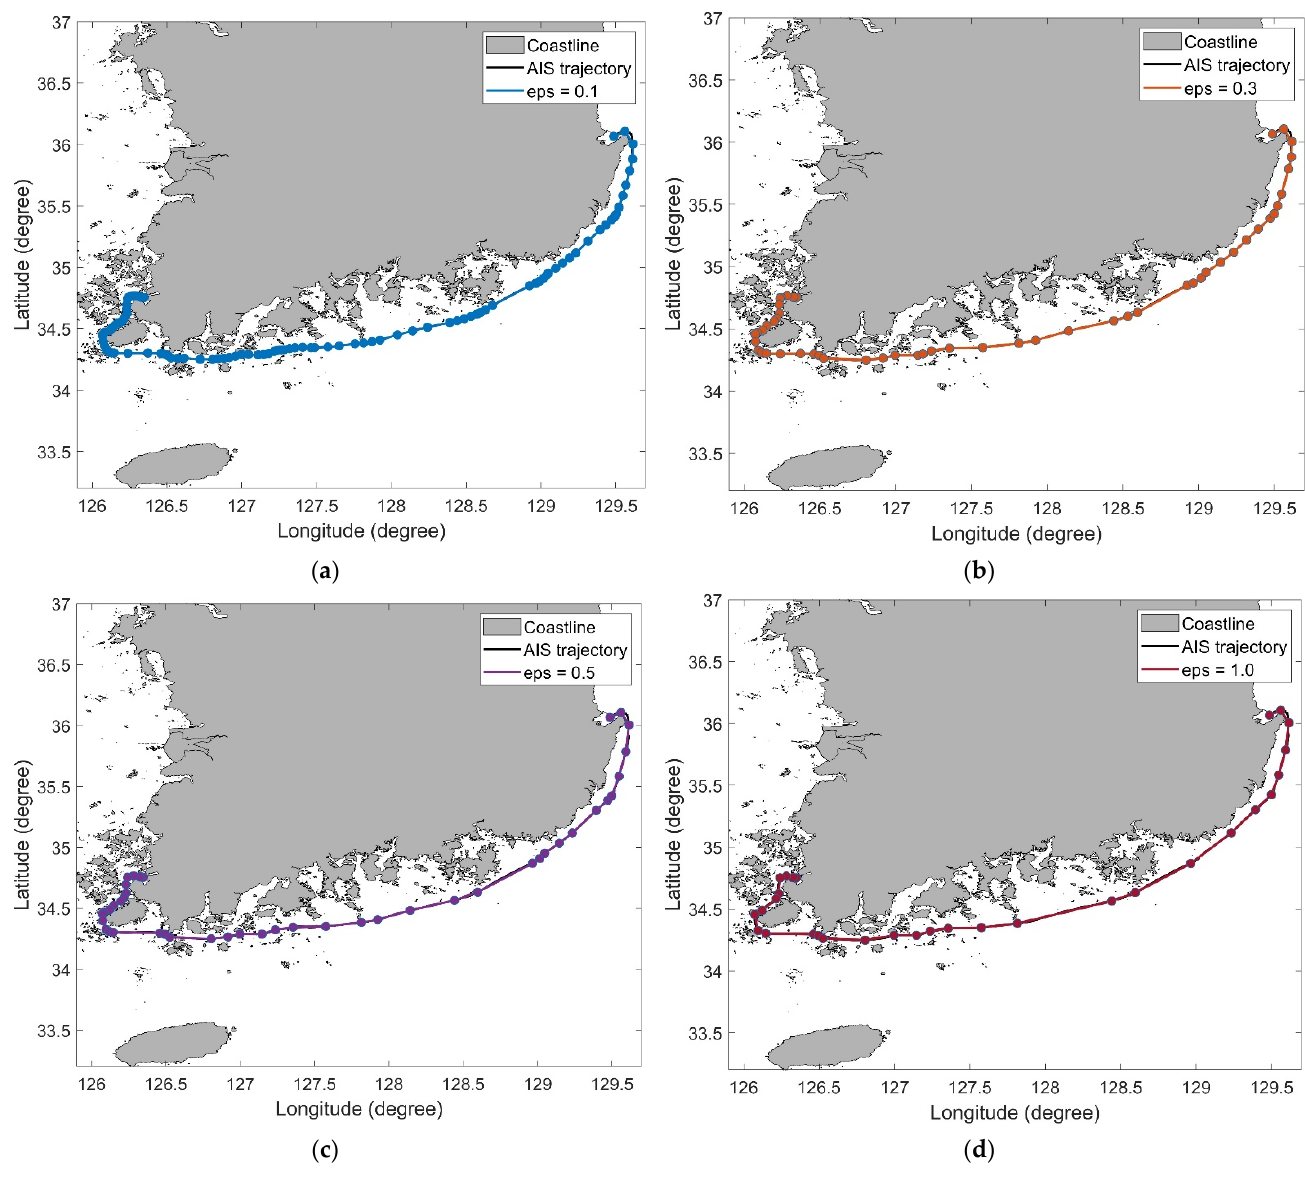
Figure 9. AIS trajectory simplification results of the ODP algorithm for trajectory 10: ( a ) 𝜖 = 0.1 ; ( b ) 𝜖 = 0.3 ; ( c ) 𝜖 = 0.5 ; ( d ) 𝜖 = 1.0 .